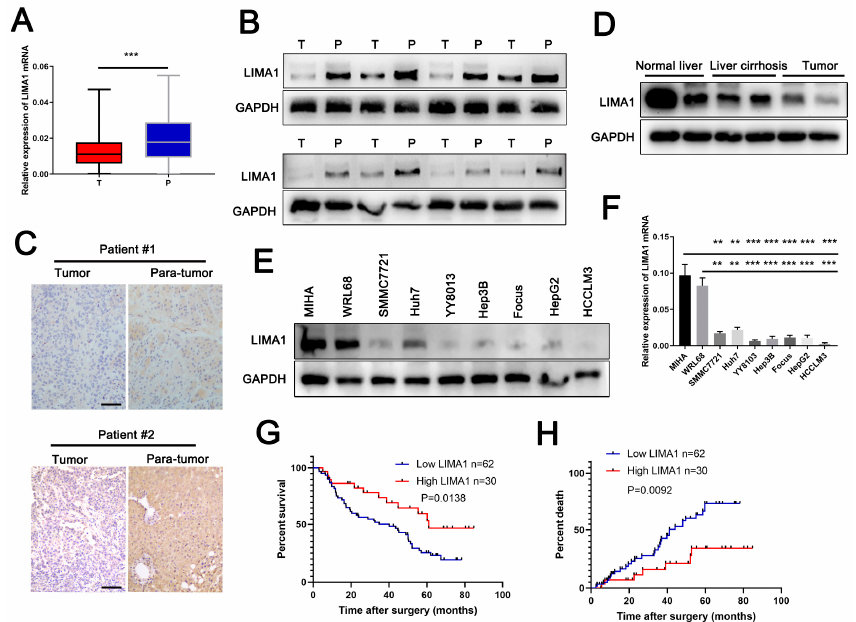
Figure 1. LIMA1 is downregulated in HCC tissues and cells. ( A ) RT-qPCR detection of LIMA1 mRNA expression in ninety-two pairs of HCC tissues. ( B ) Western blotting detection of LIMA1 protein expression in eight pairs of randomly selected HCC tissues. ( C ) IHC detection of LIMA1 protein expression in HCC tissues. ( D ) Western blotting detection of LIMA1 protein expression in normal liver, liver cirrhosis and HCC tissues. RT-qPCR ( E ) and western blotting ( F ) detection of LIMA1 expression in HCC cell lines and normal liver cells. ( G ) Overall survival (OS) and ( H ) recurrence-free survival (RFS) of HCC patients in the LIMA1-high and LIMA1-low groups. ** p < 0.01, *** p < 0.001.